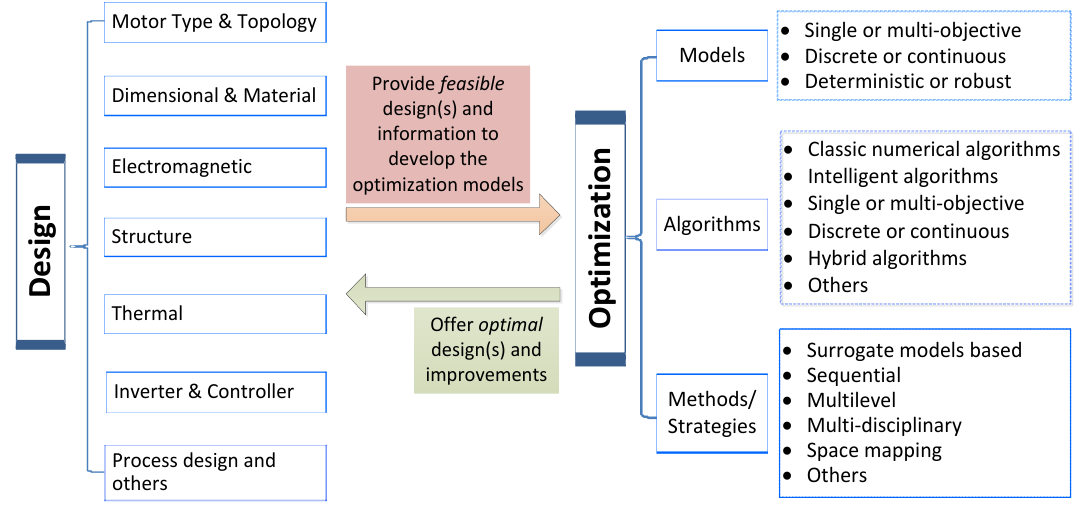
Figure 2. Main aspects covered in the design and optimization of electrical machines.